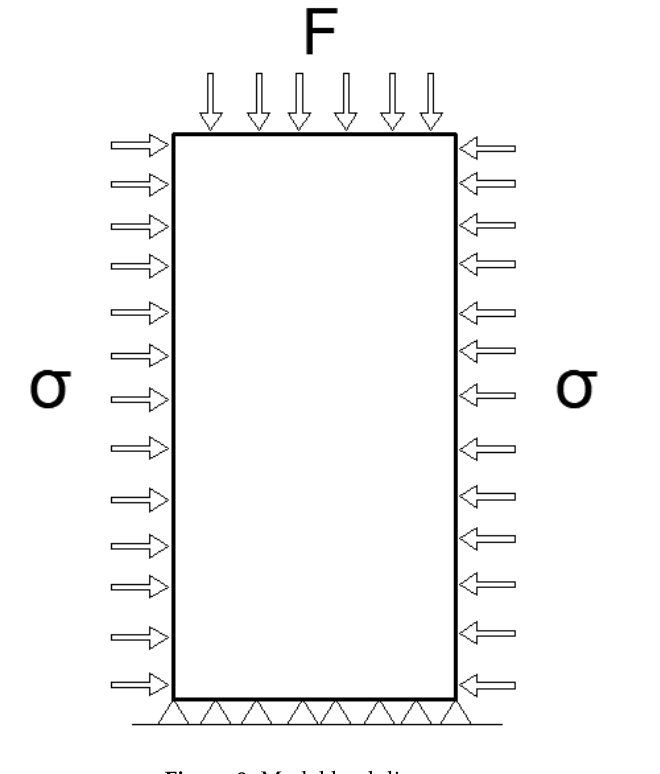
Figure 9. Model load diagram. Table 3. Basic parameters of the model.